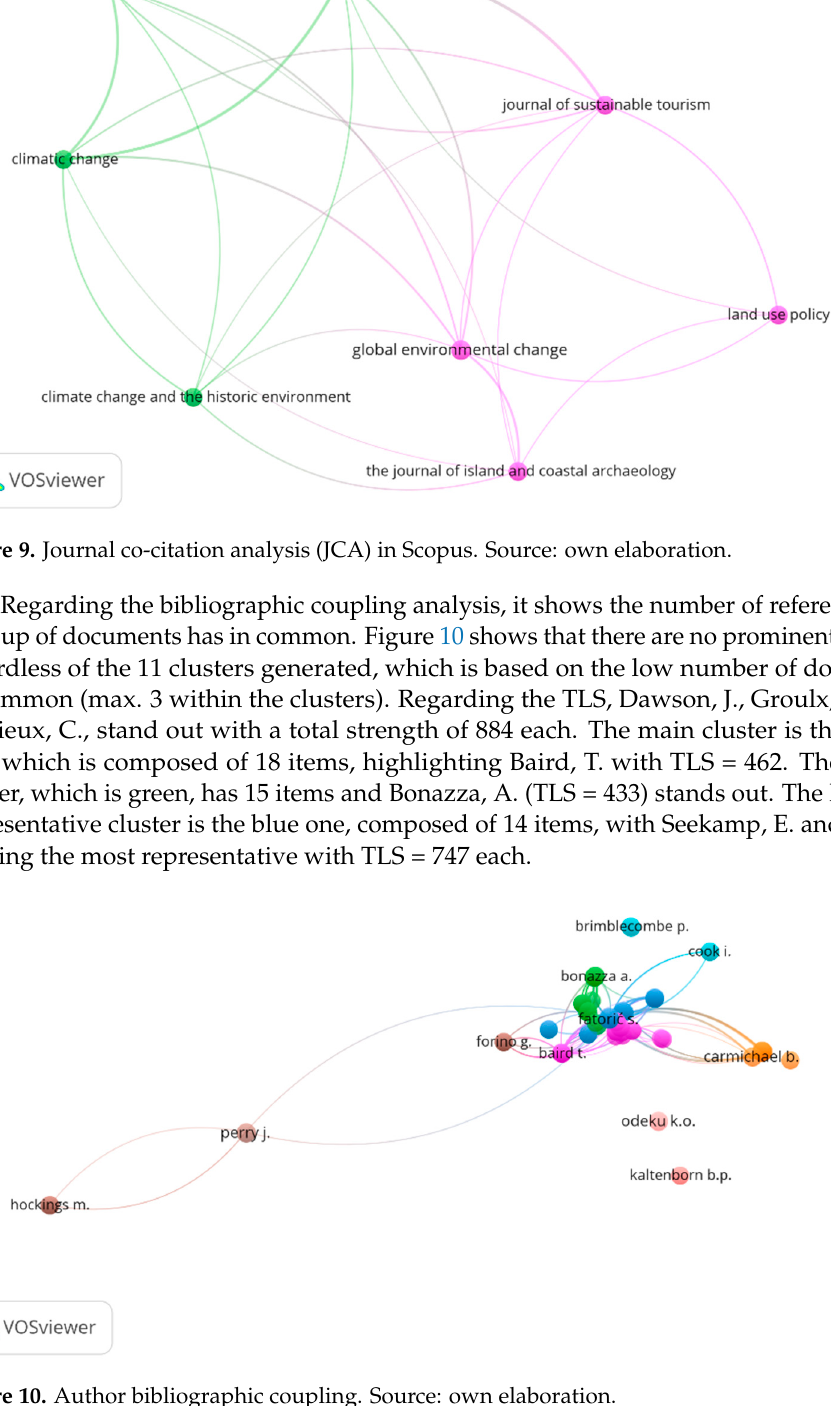
Figure 10. Author bibliographic coupling. Source: own elaboration.